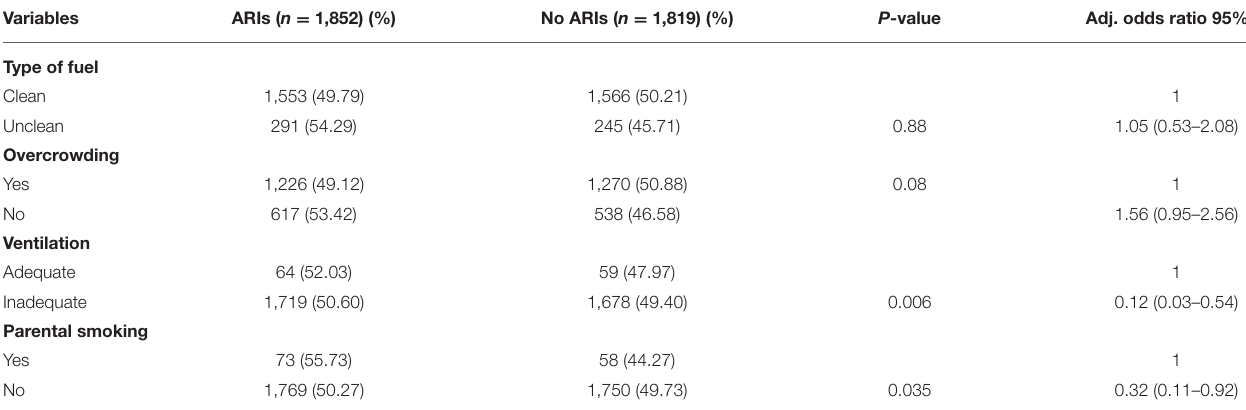
TABLE 2 | Distribution of the children with ARI according to the household environmental